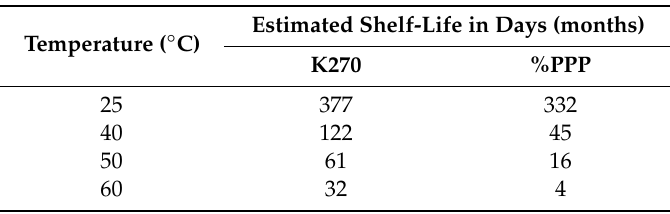
Table 4. Estimated shelf-life (days) at 25, 40, 50 and 60 ◦ C by using K270 or %PPP as quality indicators.